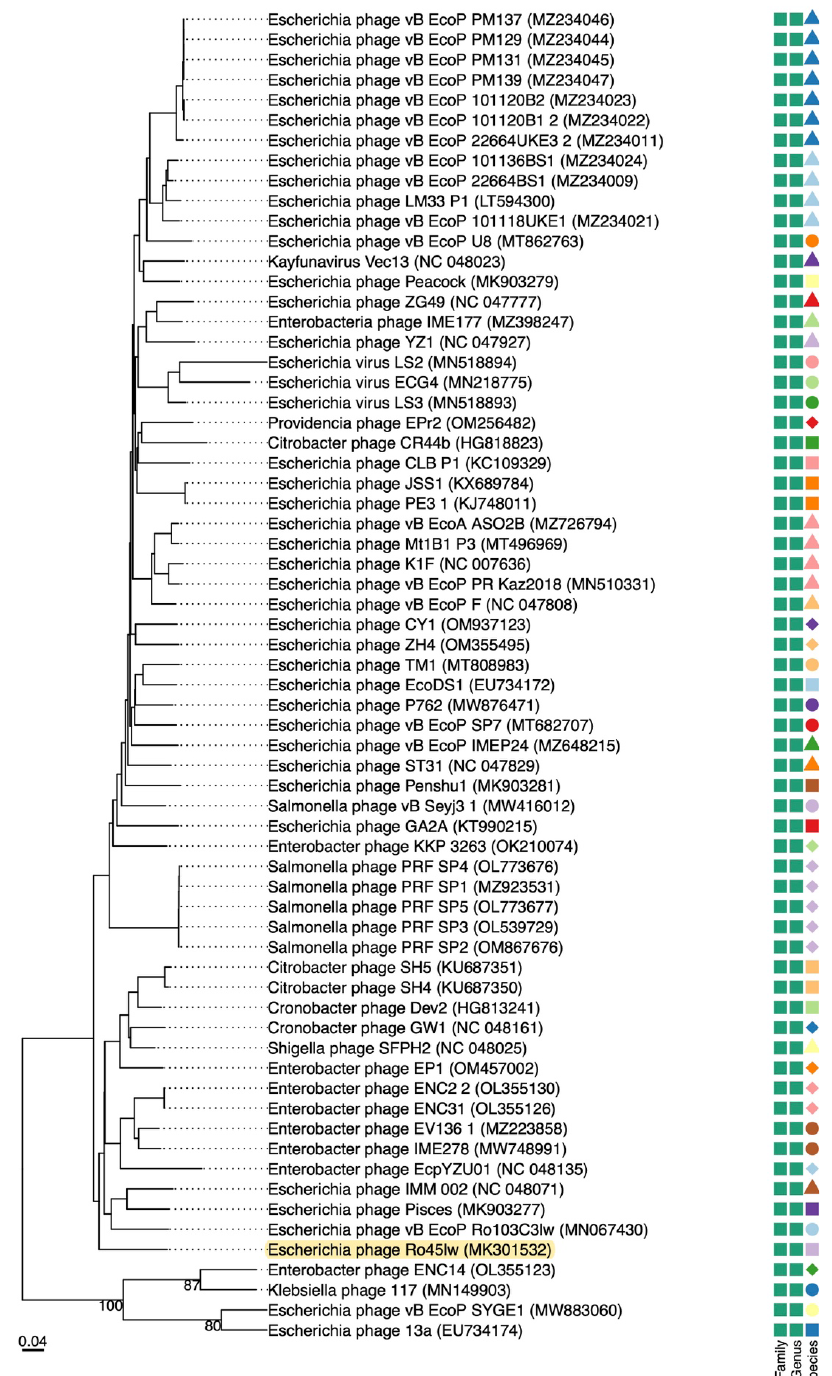
Figure 2. Phylogenetic analysis of whole-genome sequences of Ro45lw and its closely related reference phages belonging to the Kayfunavirus genus under the Autographiviridae family at the amino acid level using VICTOR (formula d6). Annotations, including family, genus, and species cluster predicted by VICTOR, with different shapes and colors, are different in